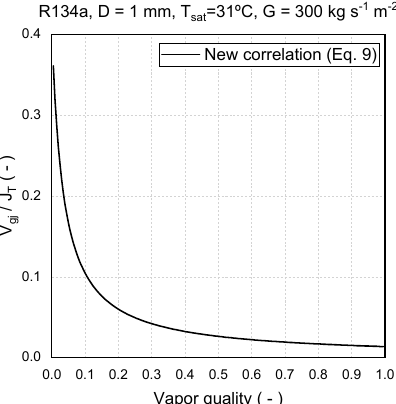
Figure 12. Ratio between the drift velocity and the mixture velocity in function of the quality.